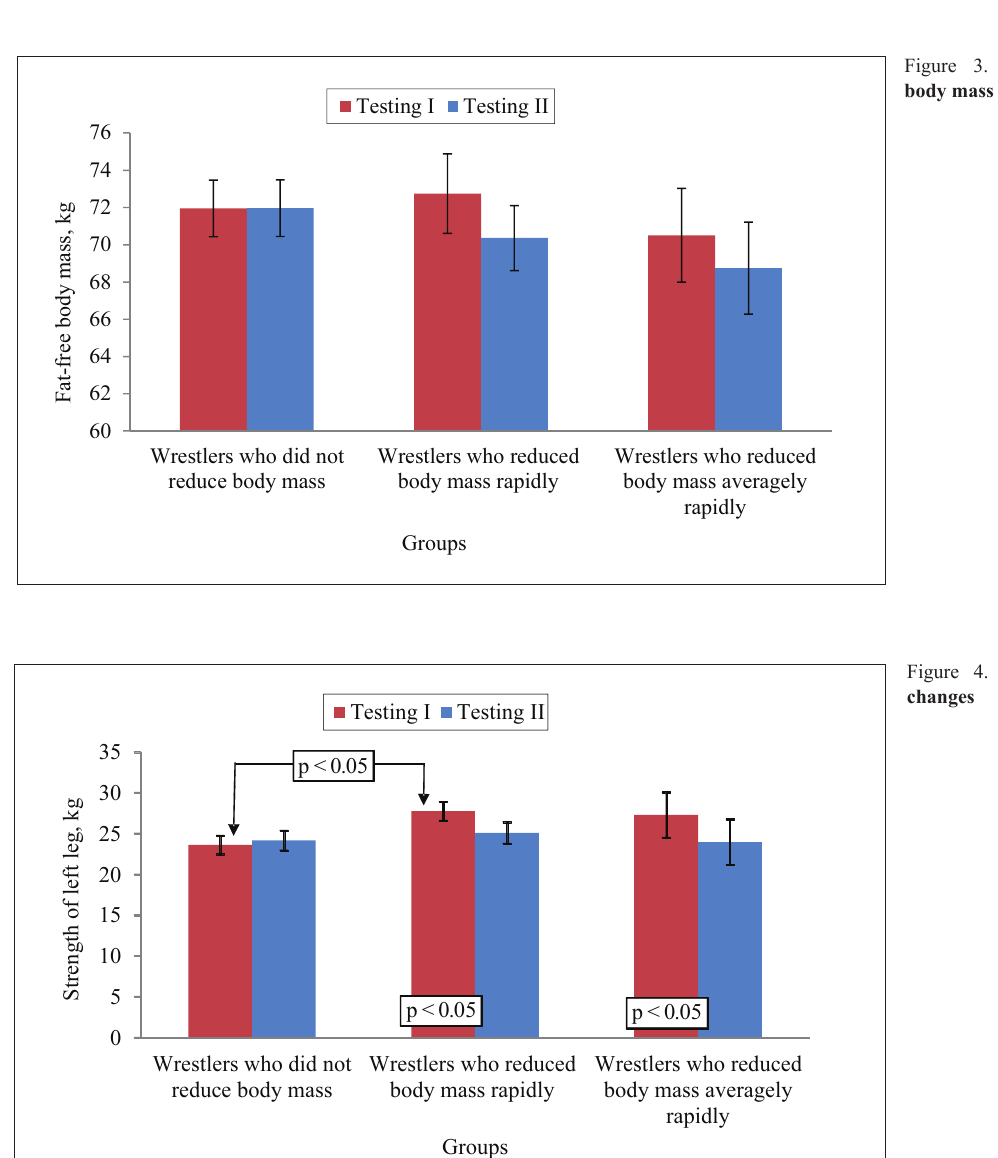
Figure 4. Wrestlers’ left leg changes